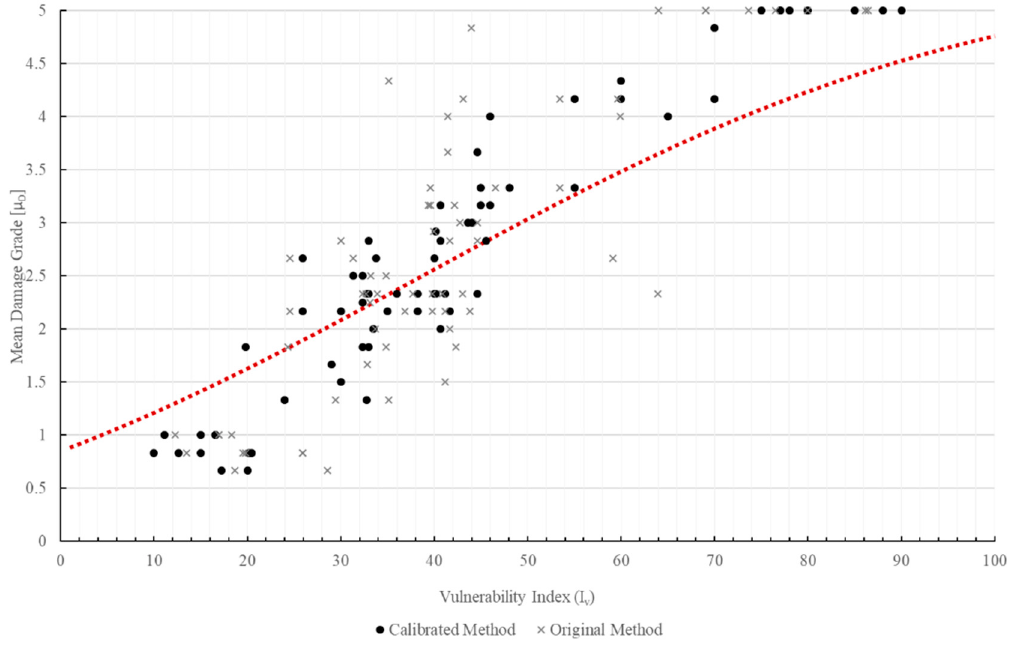
Figure 18. Comparison between the original and the calibrated results. Table 7. New calibrated weights for Vicente method.